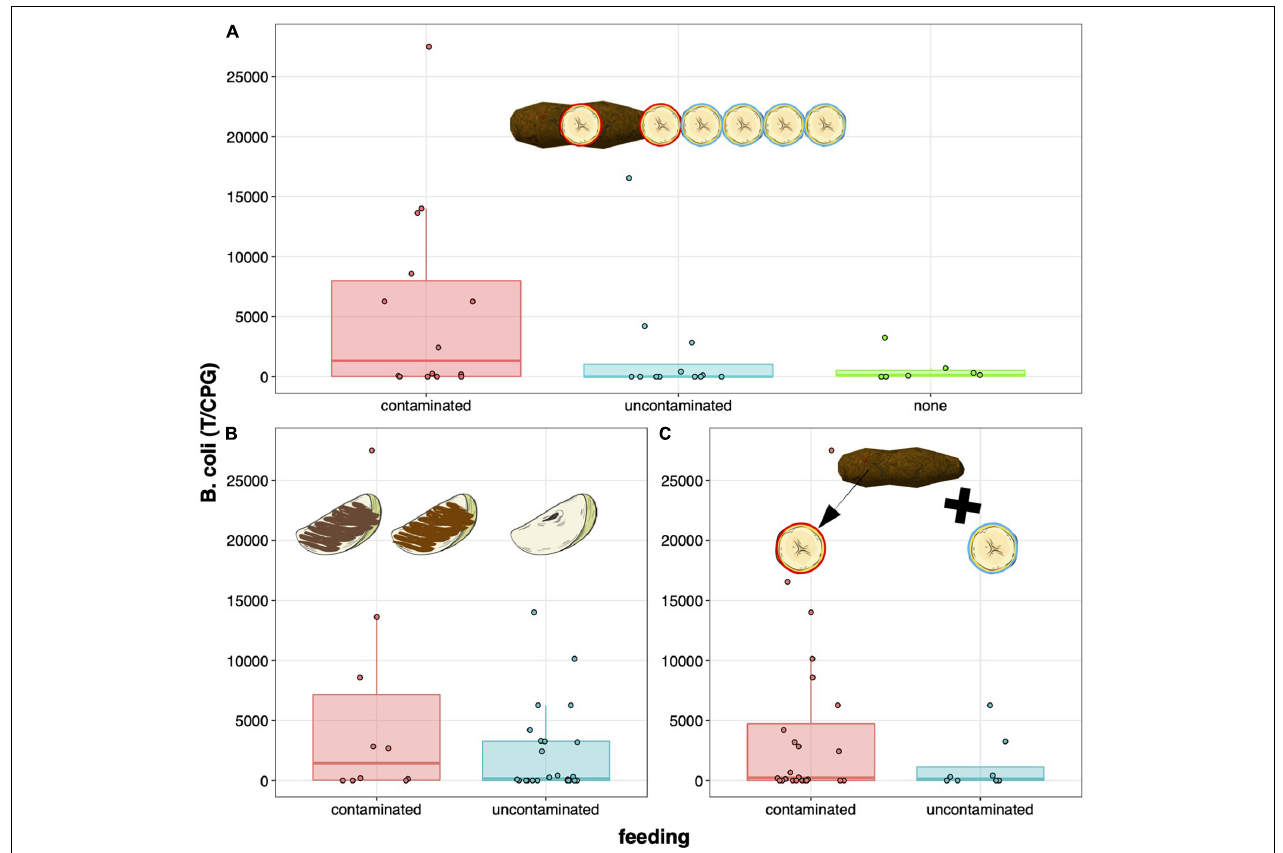
FIGURE 1 | Levels of Balantioides coli infection (average number of trophozoites/cysts per gram of feces) according to feeding decisions in bonobos exposed to (A) a chain of contagion in exp. #2; (B) soil- and fecally-contaminated apple slices in exp. #1; and (C) previous contamination in exp. #3. Individuals (dots) feeding on contaminated food (red boxplots) tended to be significantly more infected with B. coli than individuals feeding on control food (blue boxplots) or not feeding at all (green boxplot in exp. #2).